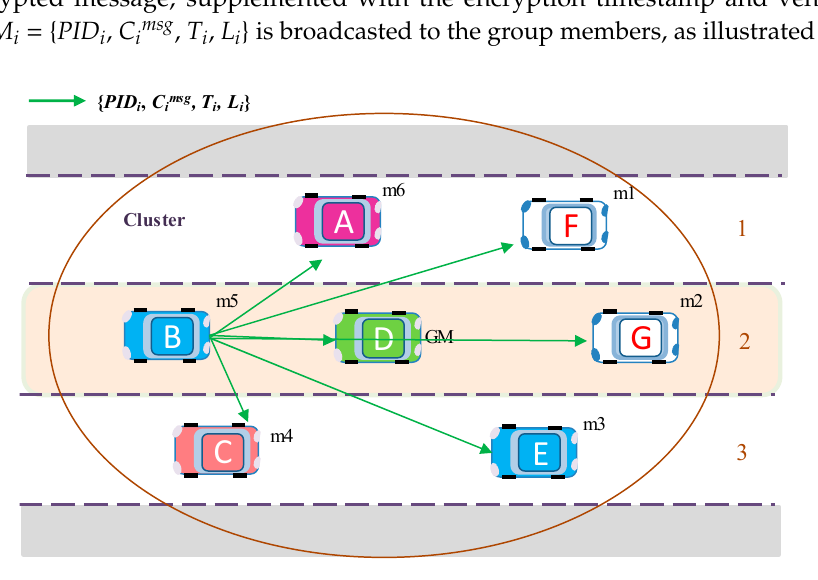
Figure 11. Encrypted message broadcasting in the group.